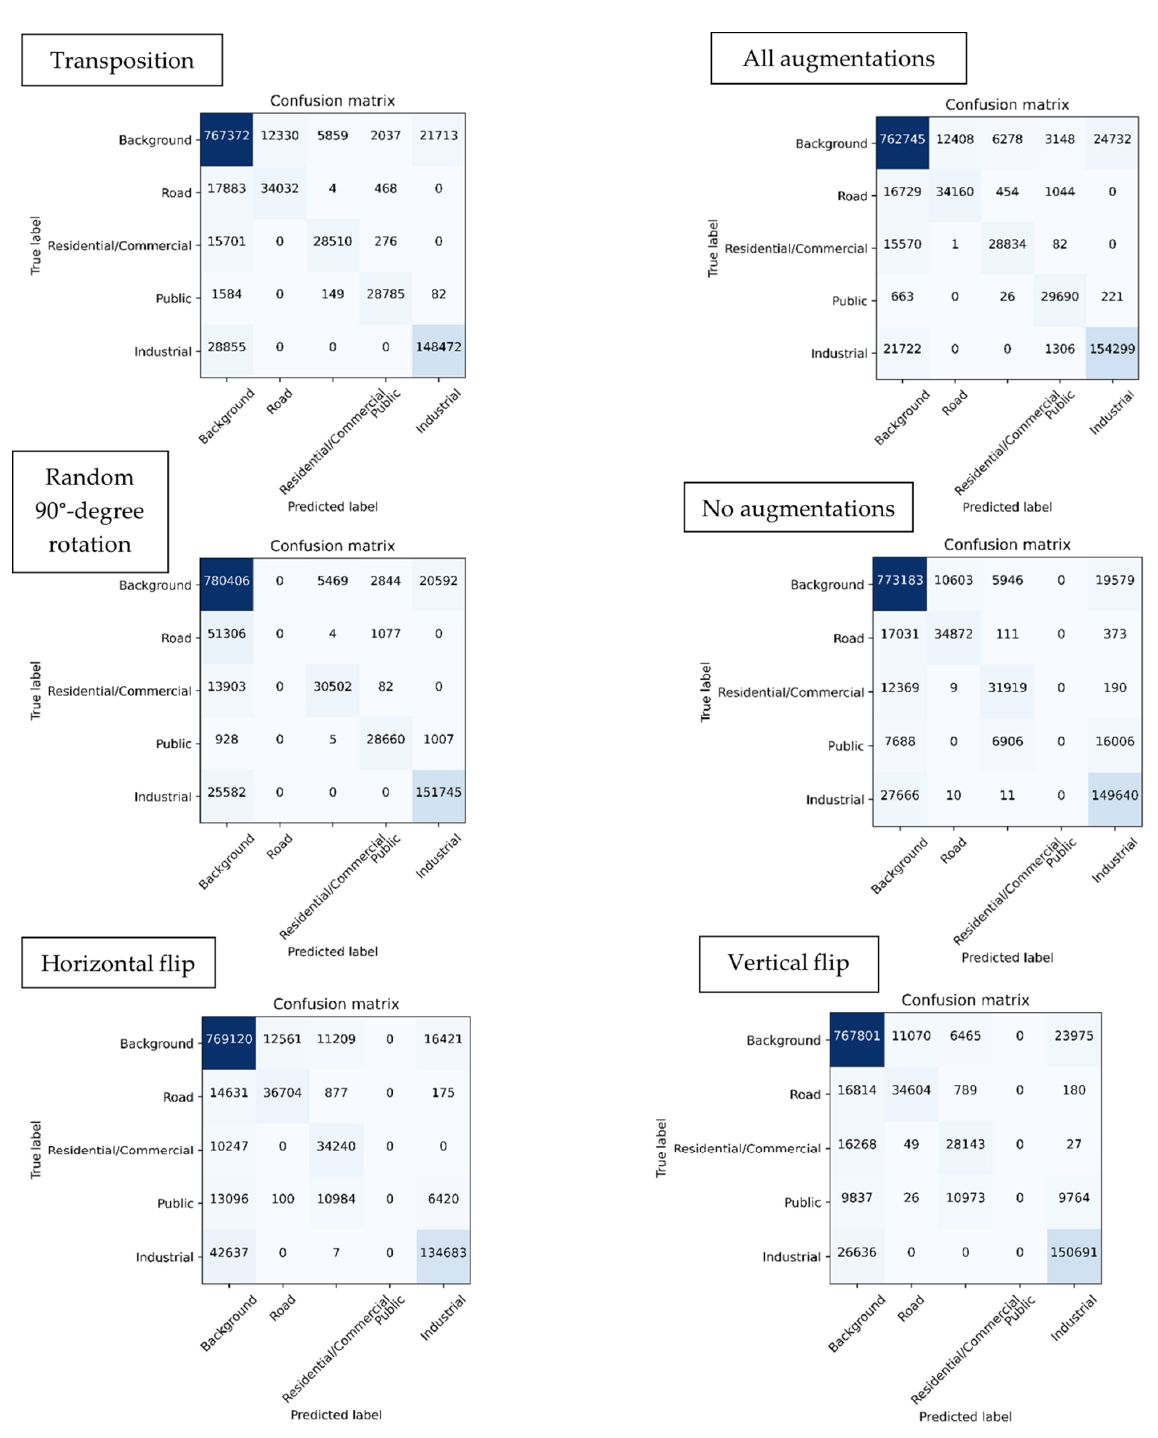
Figure 6. Confusion matrices from each model trained under the augmentation experiment. The matrices, starting from top left to bottom right, are ordered from left to right by the average F1 score achieved by the corresponding model. Horizontal axis indicates the pixel class predicted by the model, and vertical axis indicates the true pixel class. Number in each cell of the matrix indicates number of pixels.